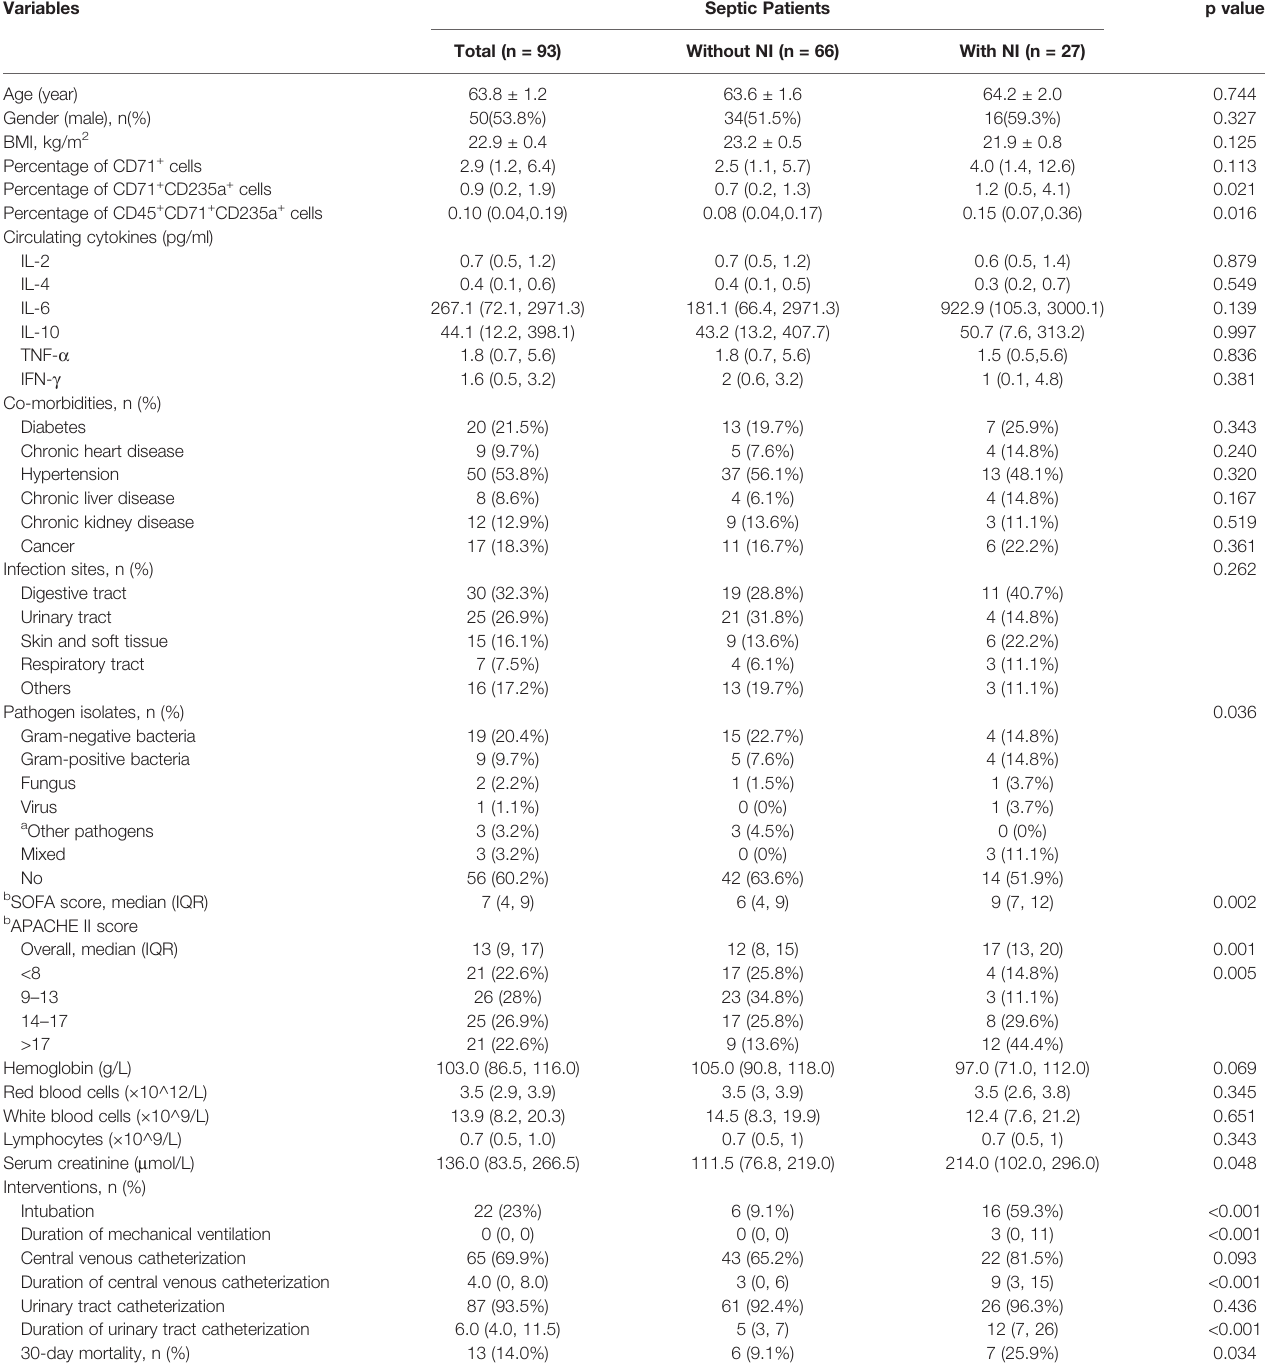
TABLE 1 | Baseline characteristics of septic patients with and without